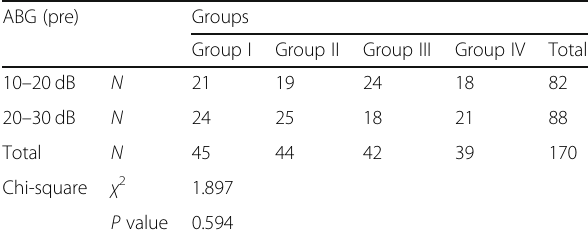
Table 2 Preoperative ABG for patients with successfully taken grafts ABG (pre) Groups